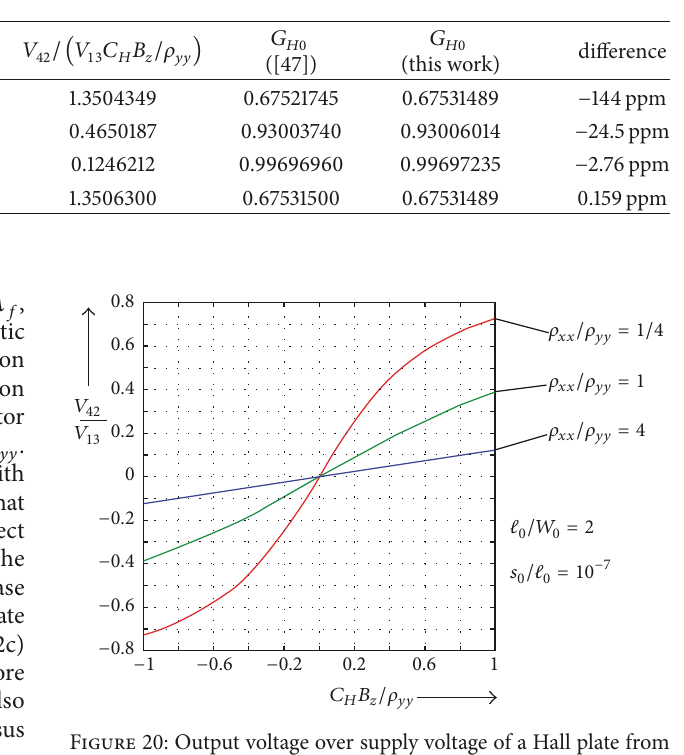
Table 3: Comparison of 𝐺 𝐻0 between this work and [47]. The reference data of [47] were obtained by the FEM simulation from Figure 20: it is the slopes of the curves in the origin inserted into (33) and solved for 𝐺 𝐻0 . In the FEM simulation the parameters of the Hall plate from Figure 19 were ℓ 0 /𝑊 0 = 2 and 𝑠 0 /ℓ 0 = 10 −7 . The difference between both is small and it seems to come from the nonlinearity of the curves (compare first and last lines).